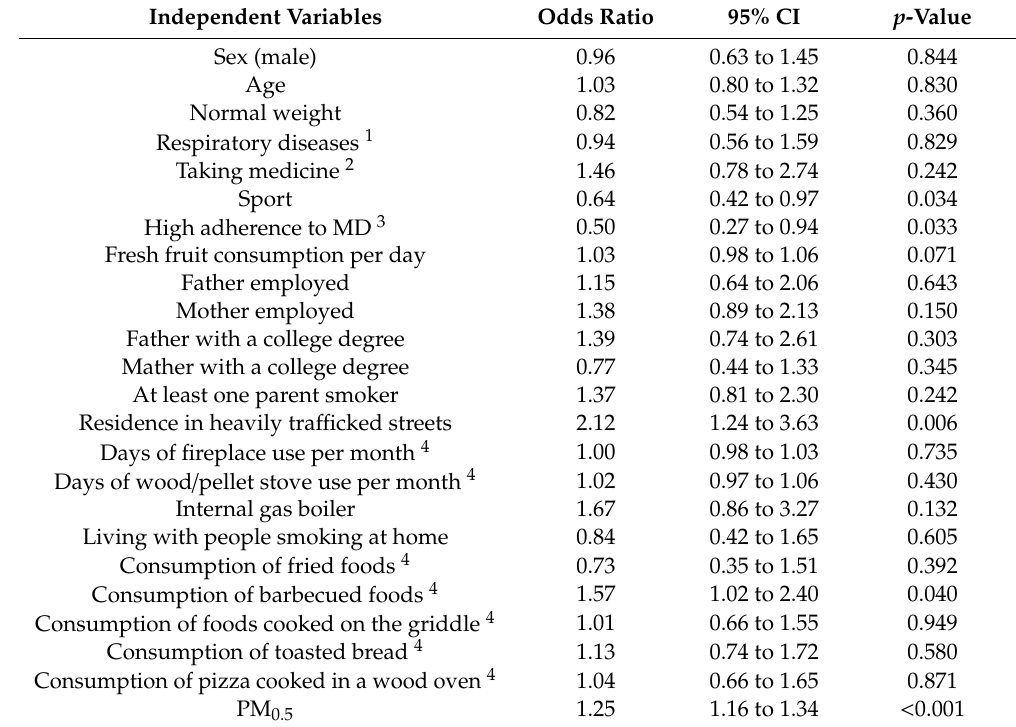
Table 7. Odds ratios (OR) and 95% confidence interval (CI) of MN frequency in EBC of children associated with individual or environmental